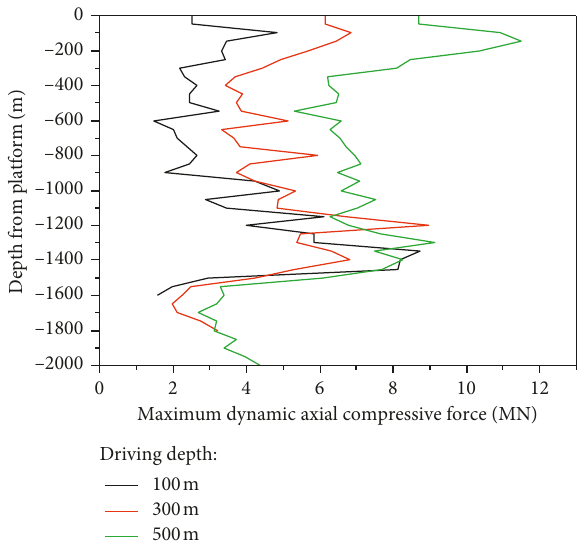
Figure 29: Effect of driving depth on maximum dynamic